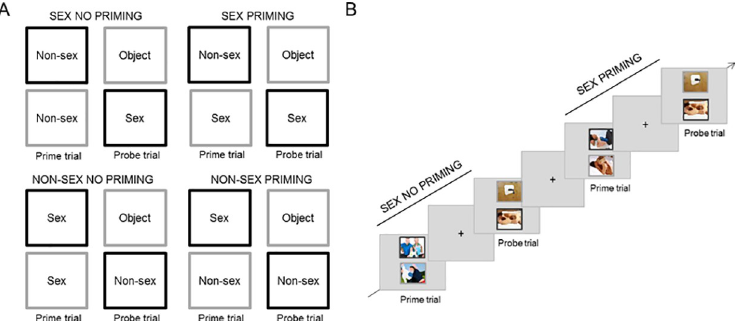
Fig 2. Cognitive sexual inhibition—Negative affective priming task. A) Priming conditions: the content of the distractor–gray frame- in the prime trial (Sex or Non-Sex) matched the content of the target–black frame- in the probe trial. No Priming conditions: the content of the distractor in the prime trial was different from the content of the target in the probe trial. B) Timeline: Example of a Sex No Priming and a Sex Priming trial sequence.